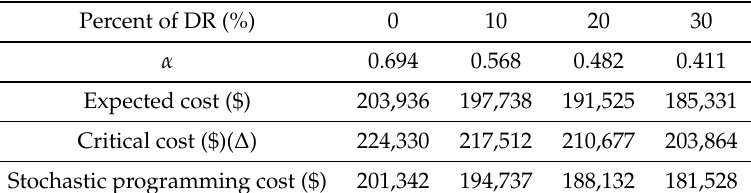
Table 2. A comparison of the stochastic programming method and Information Gap Decision Theory (IGDT).